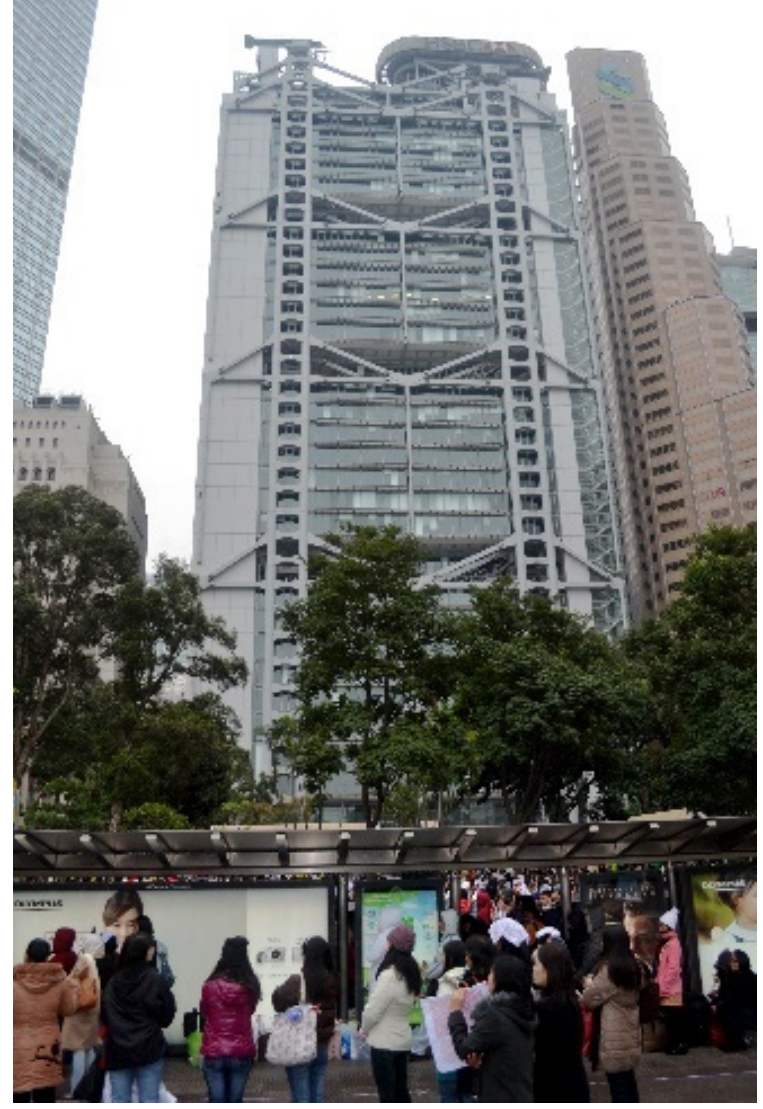
Figure 23. The Hong Kong and Shanghai Bank Corporation (HSBC) Headquarters Building (1985) in Hong Kong. (Photo by K. Al-Kodmany).